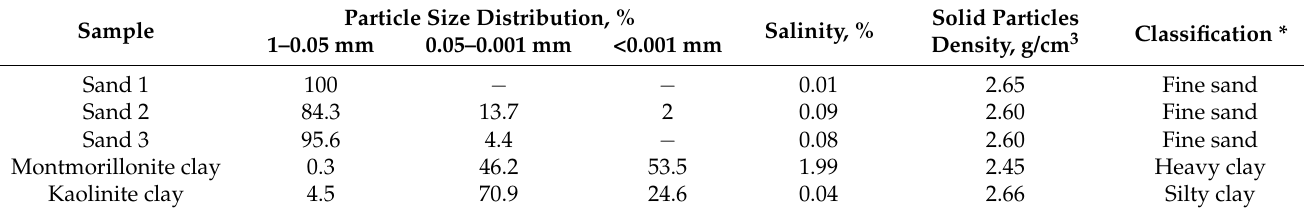
Table 2. Properties of samples.